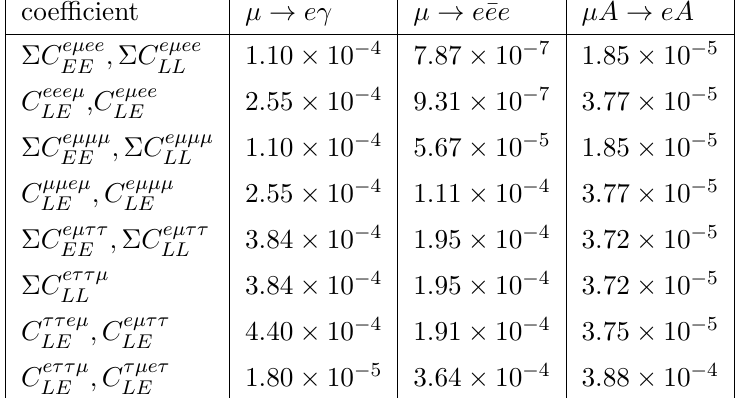
and P C ζ are defined in LL RR